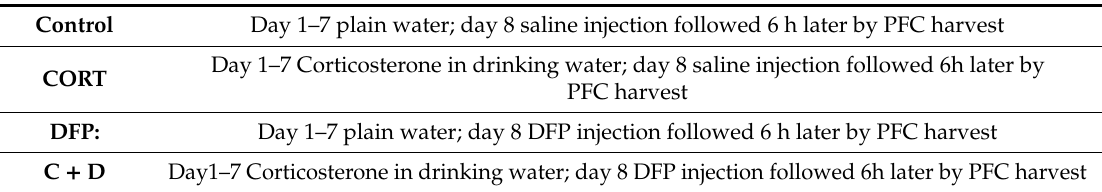
Table 1. Experimental design of the study by treatment